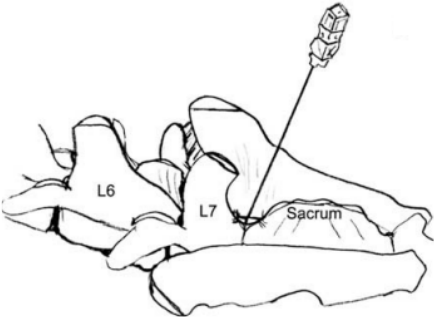
Figure 4. Anatomical position to identify the point of insertion of the needle [58].